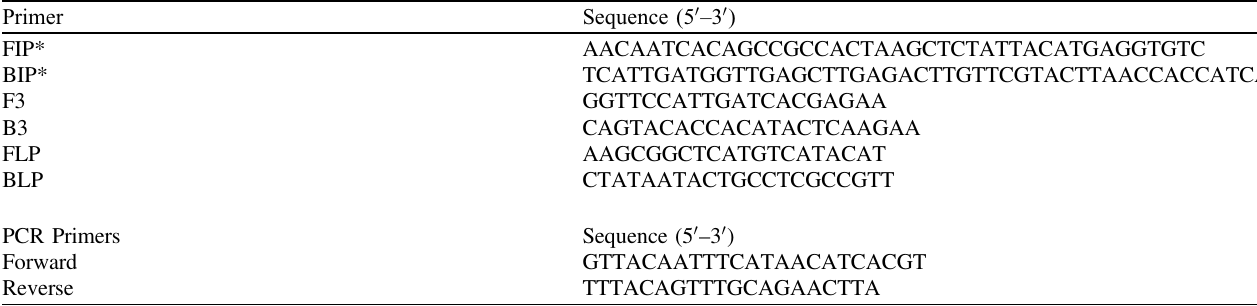
Table 2. LAMP and PCR primer sequences used.